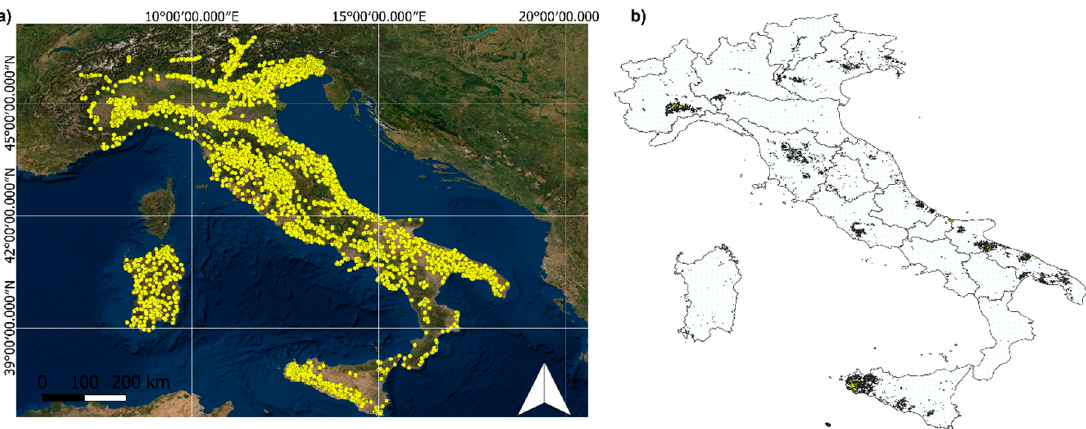
Figure 1. ( a ) Identification of the centroids of the 3686 sample vineyards (yellow dots). ( b ) Political map of Italy with the vineyard land cover (shading). Source: Copernicus CORINE Land Cover (CLC) 2018 (https://land.copernicus.eu/).